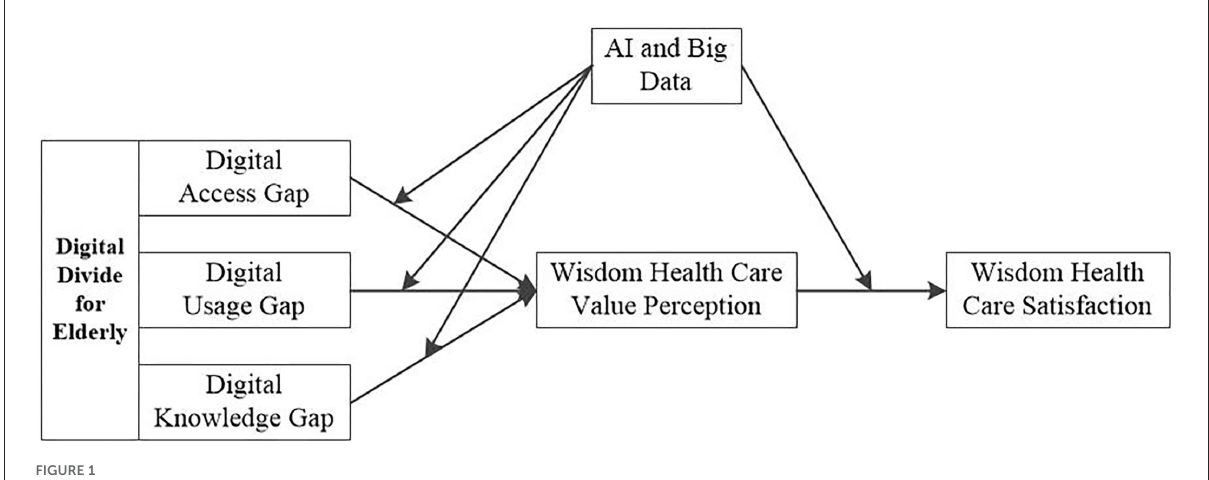
FIGURE1 Research